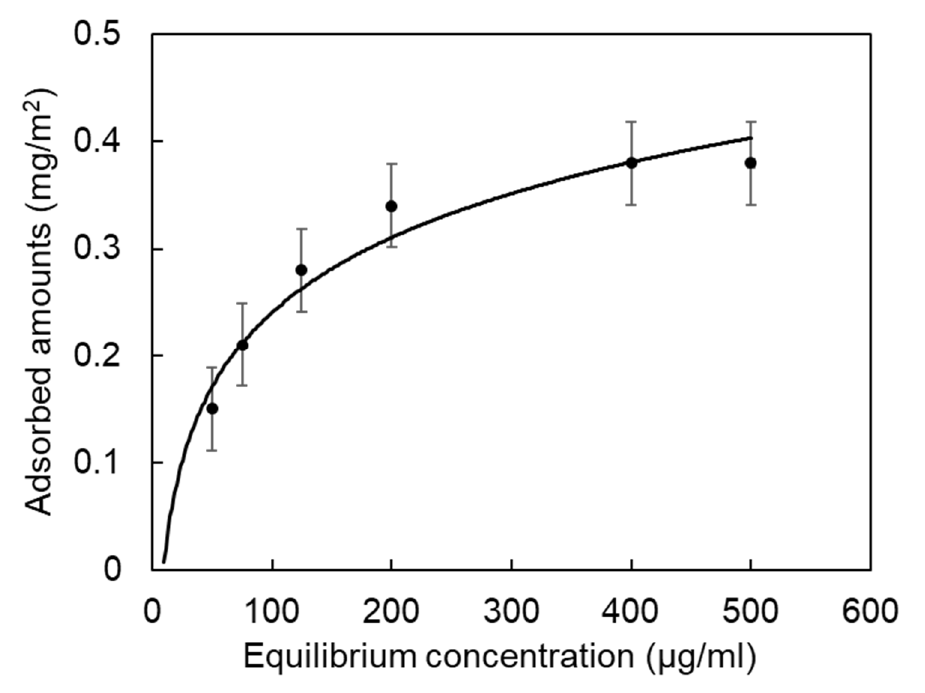
Figure 3. Adsorption isotherm for the His-Mms6 protein interacting with the magnetite nanoparticles. The dissociation constant obtained from the curve fitting was Kd = 9.52 µM.